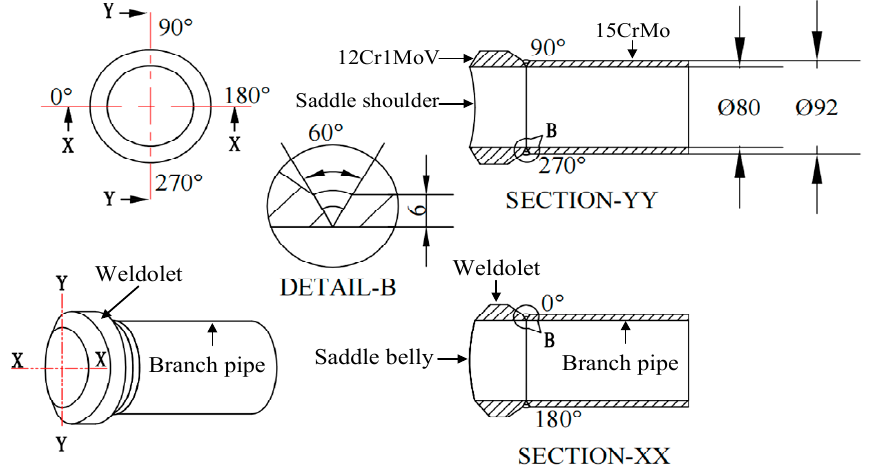
Figure 1. Two-dimensional (2D) diagram of the weldolet–branch pipe structure. Figure 1. Two ‐ dimensional (2D) diagram of the weldolet–branch pipe structure.